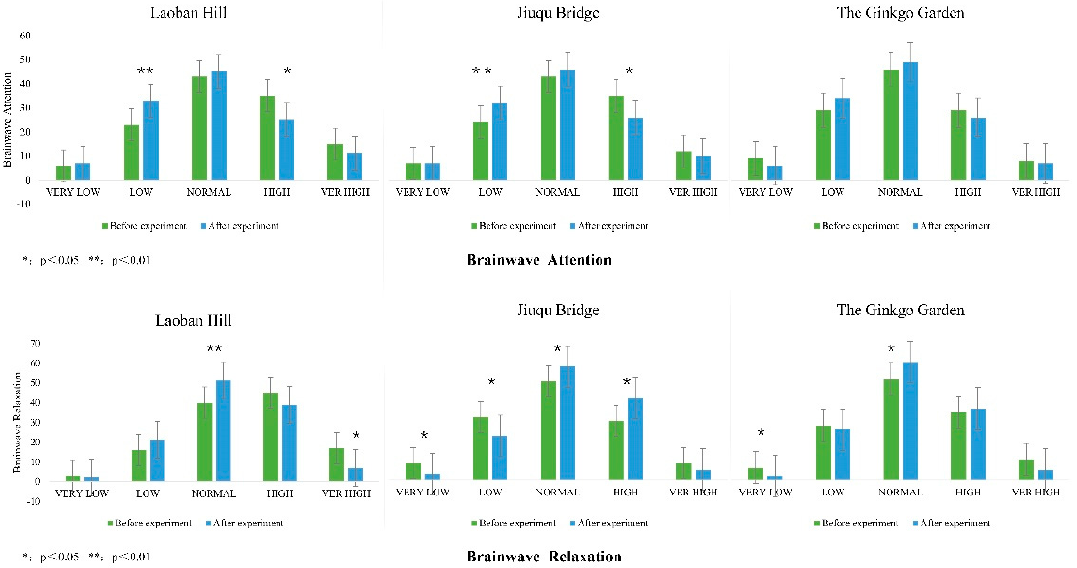
Figure 3. Brainwave Attention and Relaxation.